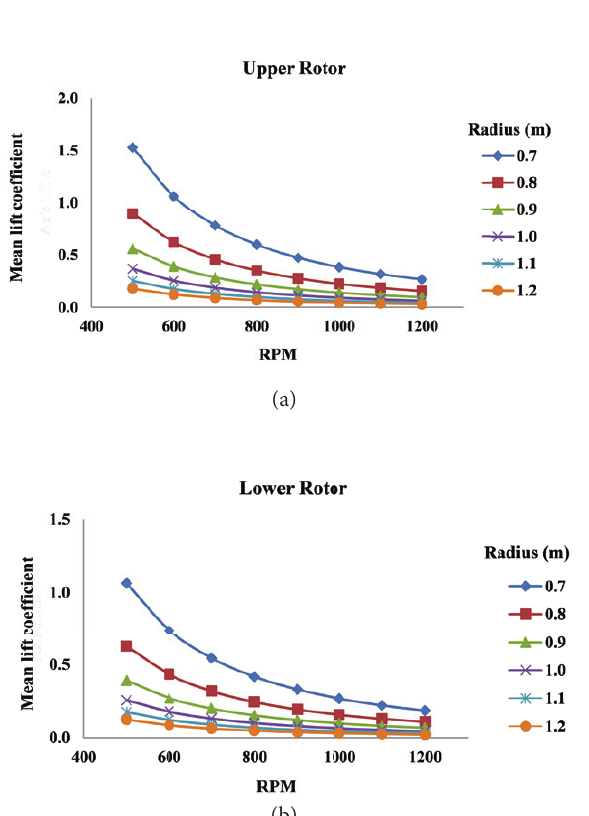
Figure 5. l C – n relation for 3-blade 2 rotor at various radiuses for upper and lower